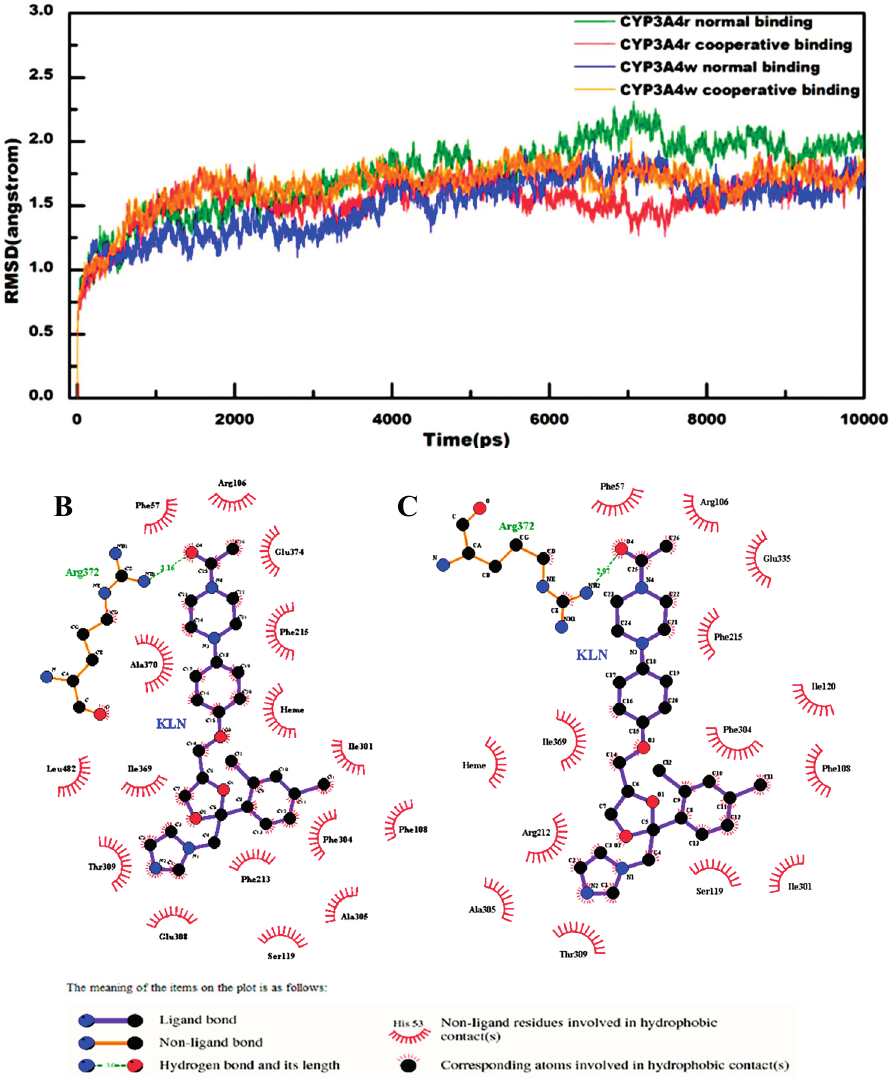
Figure 1. ( A ) RMS deviations for protein backbone structure of both normal and cooperative binding models in CYP3A4t and CYP3A4w structures; ( B ) 2D-diagram of the detailed binding information for the normal binding model in CYP3A4t structure; and ( C ) 2D-diagram of the detailed binding information for the normal binding model in CYP3A4w